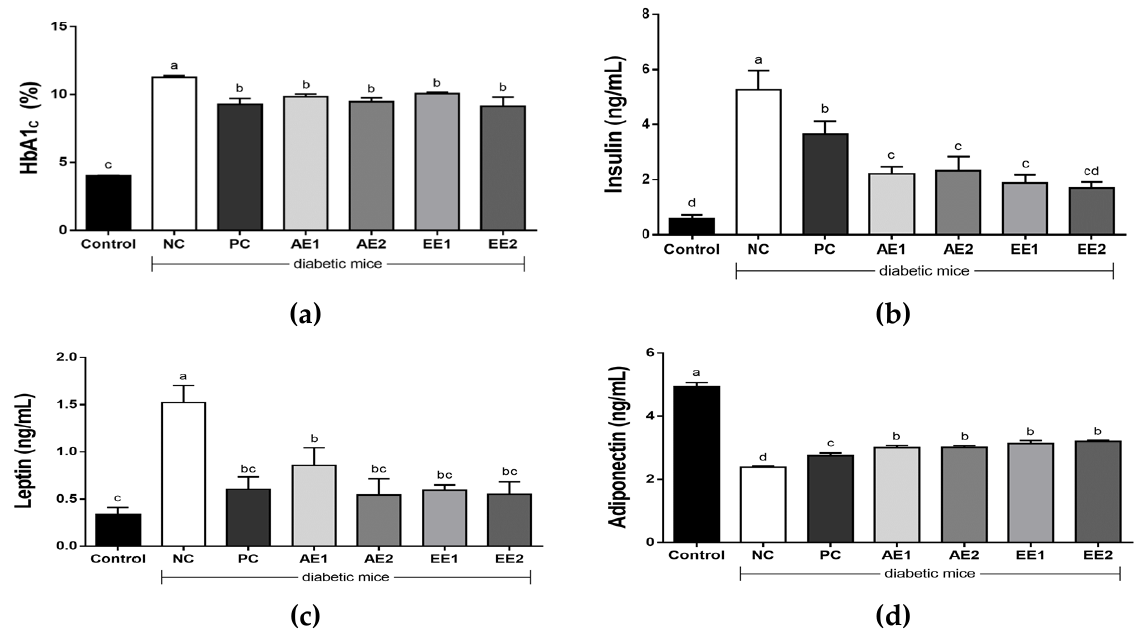
Figure 4. Effects of A. hookeri extracts on ( a ) blood HbA1c, ( b ) serum insulin, ( c ) leptin, and ( d ) adiponectin levels in the diabetic mice. Control: non-diabetic mice; NC: negative control; PC: positive control, metformin 150 mg/kg BW; AE1: aqueous extract 100 mg/kg BW; AE2: aqueous extract 200 mg/kg BW; EE1: ethanol extract 100 mg/kg BW; EE2: ethanol extract 200 mg/kg BW. AE and EE groups were treated with A. hookeri extracts for 8 weeks. Data are presented as the mean ± SEM (n = 8). a–d Mean values with different letters are significantly different at p < 0.05.